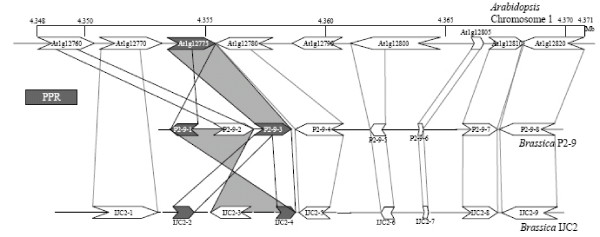
Predicted genes in two regions of Brassica napus and the syntenic segment of the Arabidopsis genome. Protein-coding sequences in the Brassica genome fragments P2-9 and IJC2 (as predicted by Genscan). For clarity, Brassica predicted genes are numbered. Protein-coding sequences in the Arabidopsis genome reflect the Munich Information Centre for Protein Sequences (MIPS) annotation. The direction of arrows indicates the direction of transcription/translation. Pairs of connecting lines indicate orthologous coding sequences between Arabidopsis and Brassica; darker pairs of lines connect orthologous PPR encoding sequences and other important sequences. Shading between connecting lines is added for emphasis and clarity. Dark-filled arrows indicate PPR encoding sequences. Brassica sequences shown are limited by the size of fragment sequenced, thus genes that are outside these sequences are not available.